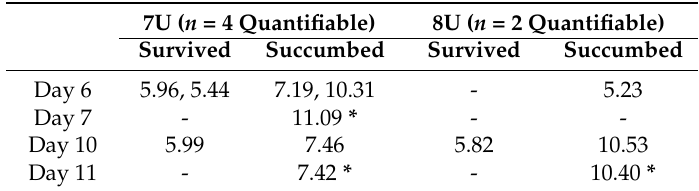
Table 1. Vaccinated NHP circulating viral genome equivalents. Each quantifiable circulating genome concentration (log 10 ) for all vaccinated monkeys in both 7U EBOV and 8U EBOV challenge groups is listed by day. Dashes represent time points for which there was no quantifiable data. Asterisks indicate a terminal event. 7U ( n = 4 Quantifiable) 8U ( n = 2